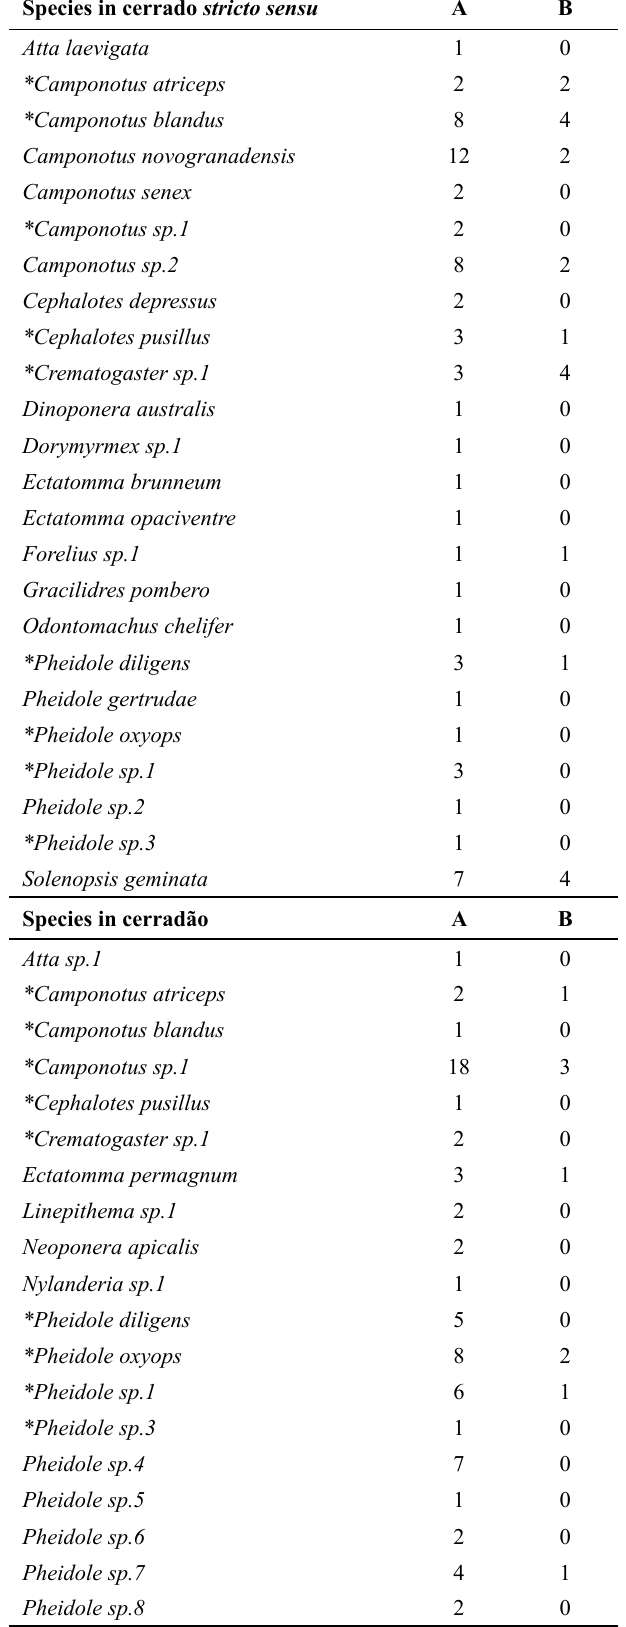
Table 2 . The number of food baits in which ant species shared the resource (A) and the number of baits in which they did not share it (dominating ants) (B) in each cerrado area. Asterisks represent species found in both studied areas.